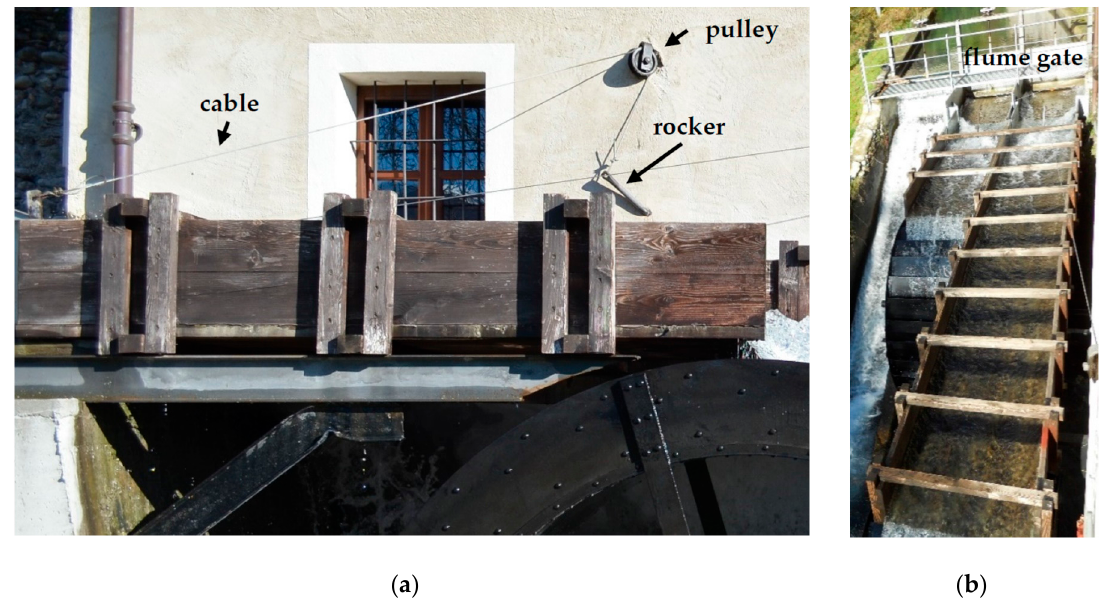
Figure 22. Regulating the supply flow rate in the Riviera mill: (a) The cable actuation; (b) the flume and the flume gate.